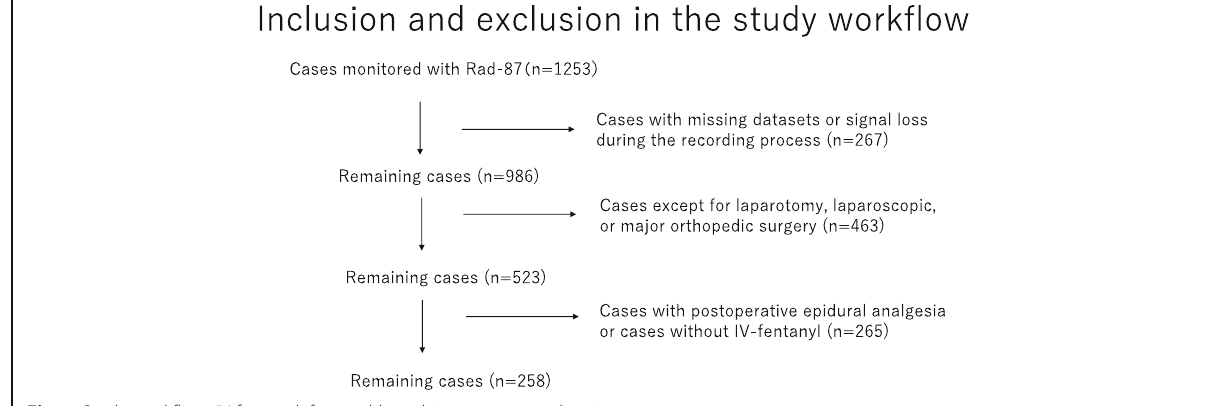
Fig. 1 Study workflow. IV-fentanyl, fentanyl-based intravenous